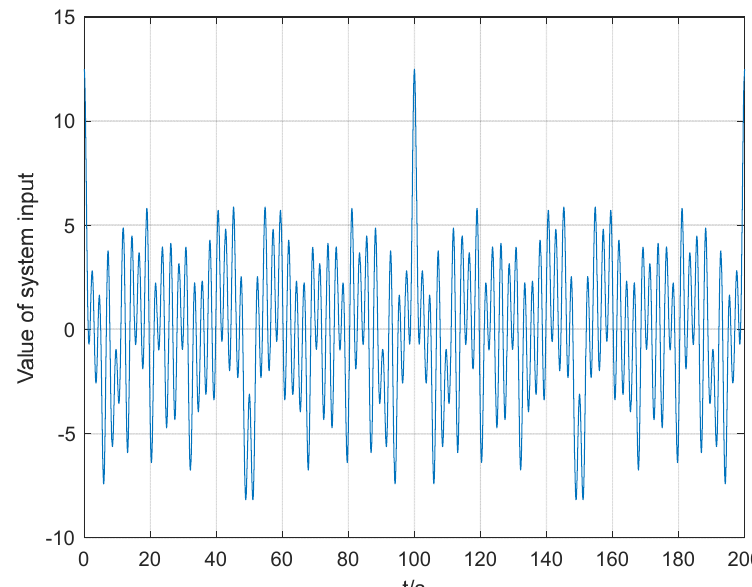
Figure 1. Input torque signal τ